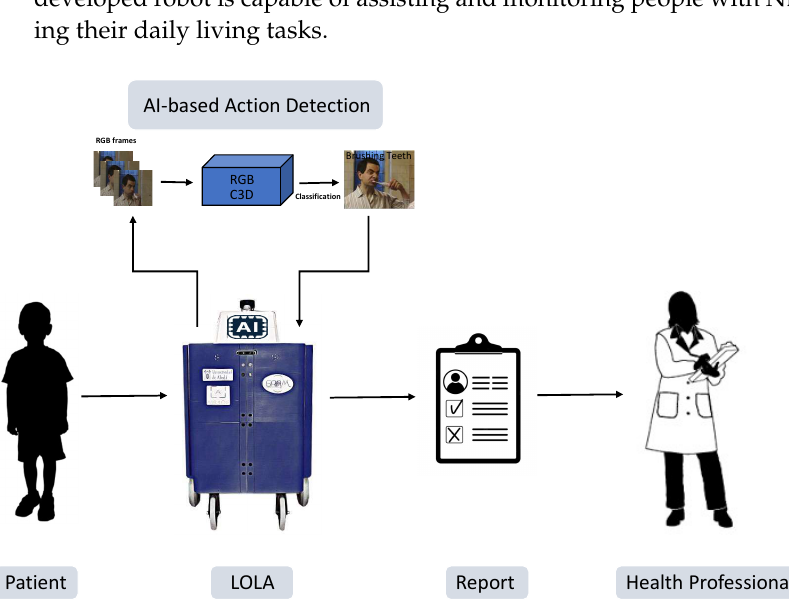
Figure 1. An overview of the action monitoring process with LOLA and users with NDDs. The patient should be placed in front of LOLA, the AI-based monitoring action model should be activated, and a report with information regarding the patient’s performance during the session will be generated and sent to the health professional in